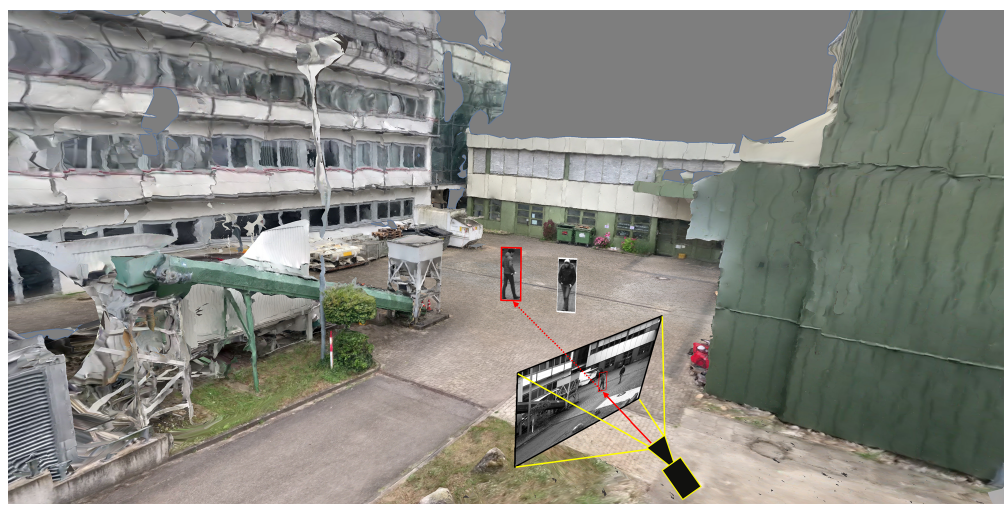
Figure 10. Its extrinsic parameters define the world coordinates of a camera in a 3D scene (camera icon). Based on intrinsic parameters, the pixel coordinate position of an object can be transformed into its respective world position through raycasting. A ray (red line) is emitted through the image at the lower edge of the bounding box of a detection (red rectangle in the camera frame). The intersection of the ray with the mesh provides the related 3D world